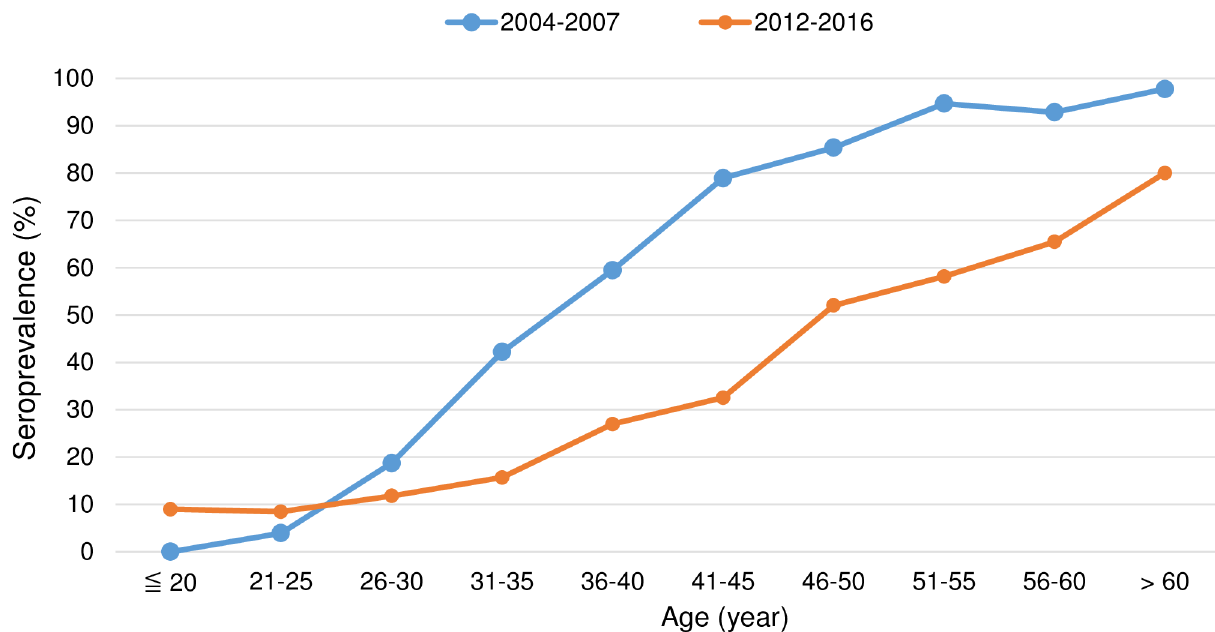
Fig 2. Comparisons of hepatitis A virus seroprevalence according to age-specific groups between the 2004–2007 cohort and the 2012–2016 cohort.